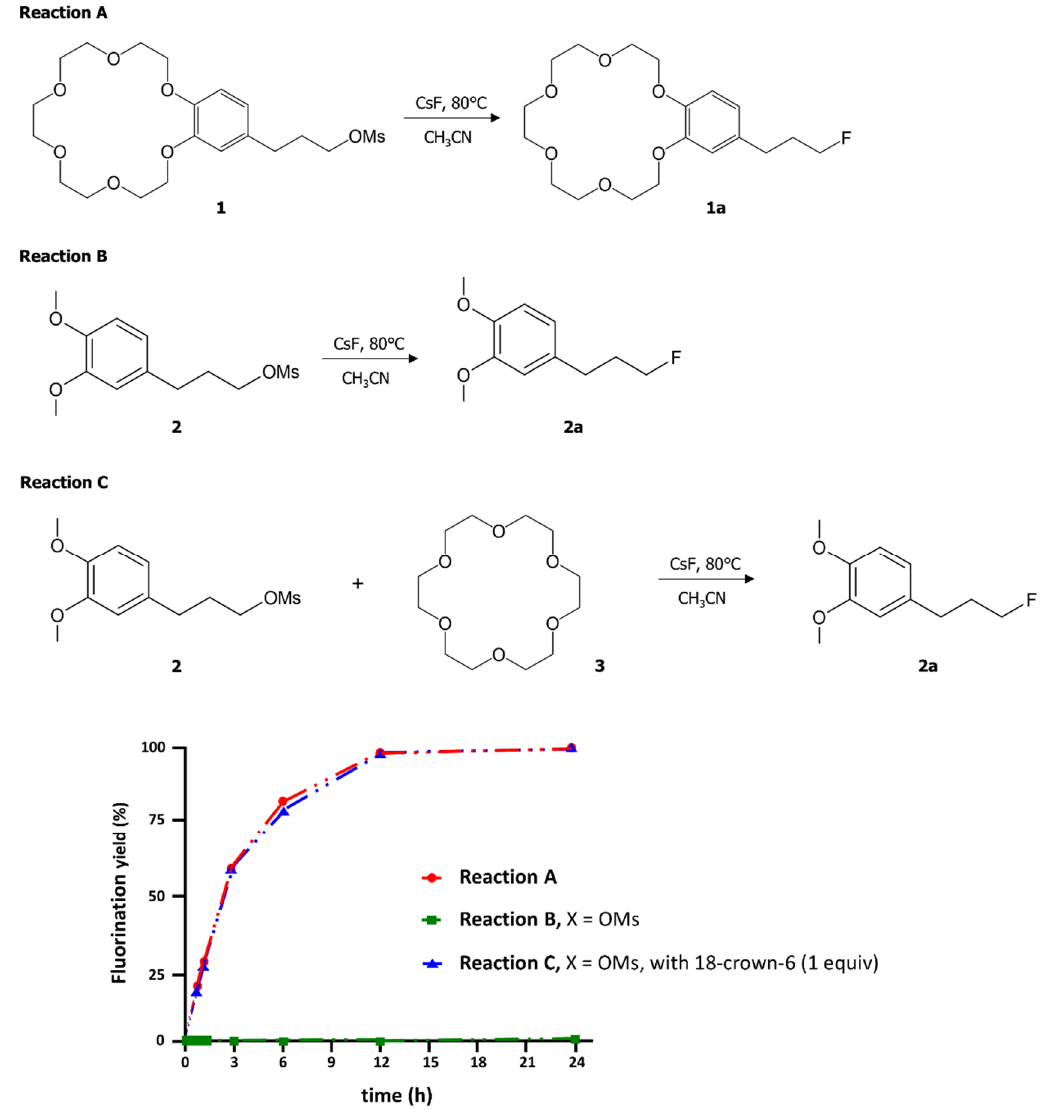
Figure 1. Intra- and inter-molecular 18-crown-6 promoted nucleophilic fluorination in comparison with S N 2 fluorination of the veratrole substrate 2 . (A) Reaction of intramolecular 18-crown-6 integrated mesylate 1 . (B) Reaction of mesylate 2 in absence of 18-crown-6. (C) Reaction of mesylate 2 with in the presence of 3 . Quantity of the products was determined using 1 H NMR spectroscopy.